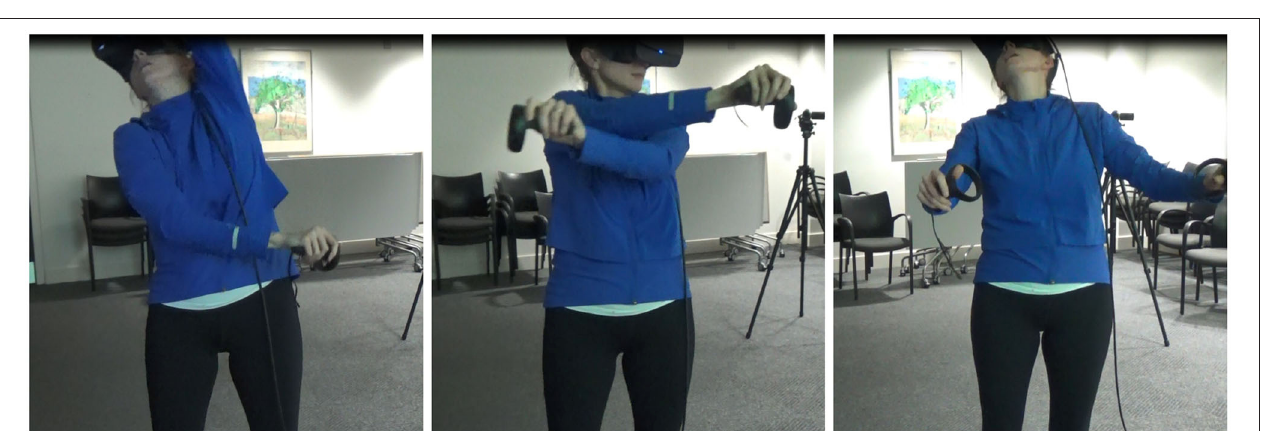
FIGURE 11 | Bodily movements and positioning showing exertion in The Climb.